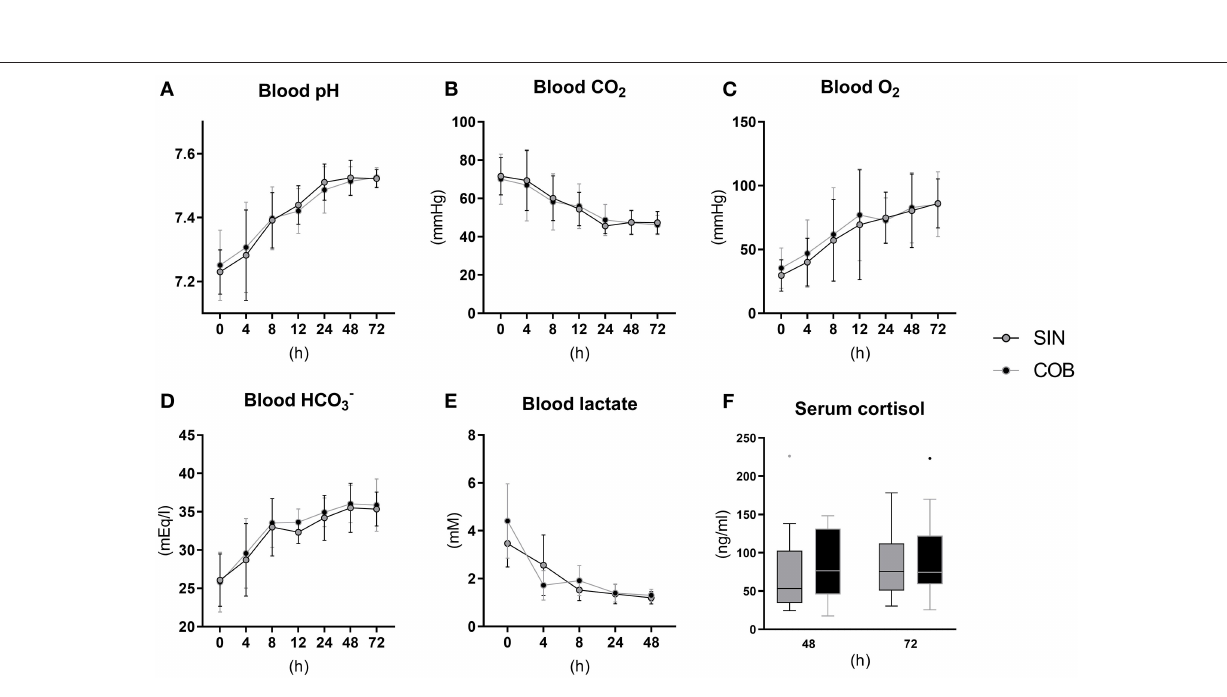
FIGURE 3 | Arterial blood gas values (A–E) and serum cortisol levels (F) in single-housed (SIN) and co-bedded (COB) Preterm piglets. Longitudinal data is presented as means with standard deviations, and cortisol data is presented in box plots (box edges denote interquartile ranges and horizontal line denotes the median value) with Tukey whiskers (outliers shown as